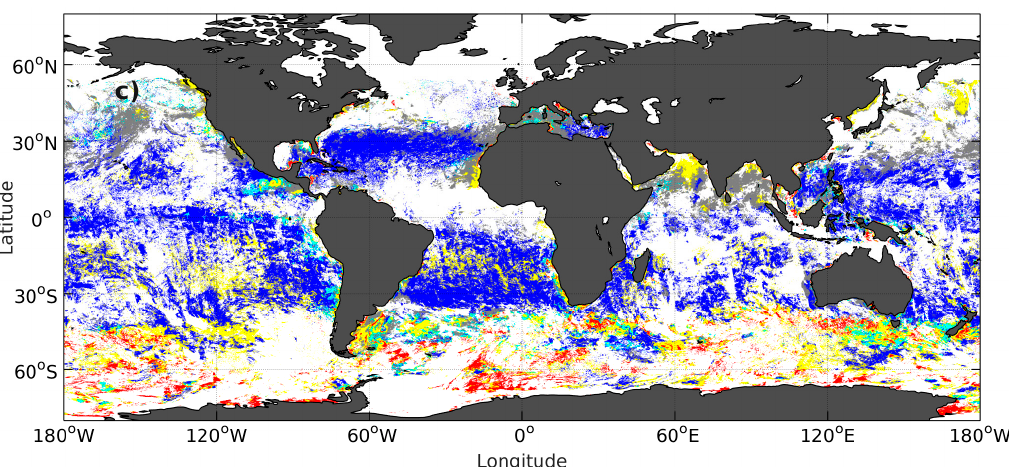
Figure 13. ( a ) The dimensionless U 1 –U 2 plane derived from the joint SVD of the typical values matrix Rt and an R matrix composed of the average MODIS-A nLw data during 4–6 February 2014. The colors represent the respective PFT assigned to each dot (pixel) considering their closeness to the fitted PFT orthomodels (black dots) shown in Figure 12. ( b ) The adjusted PFT estimation of PHYSTWO were obtained by rearranging the assignments of ( a ) in a longitude–latitude plane. ( c ) A global view of the PFT estimation performed by PHYSTWO for the same dates. Abbreviations are the same as in Figure 5.